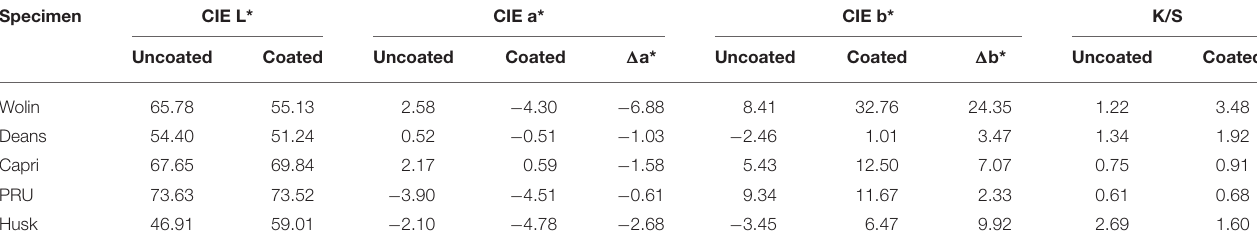
TABLE 1 | CIE Lab Colorimetric Analysis of Uncoated and SbQ-PVA/ZnTMPyP 4 + Coated Vescom Materials.